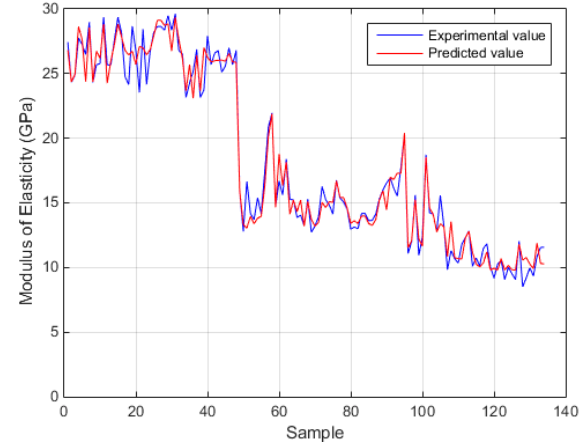
Figure 9. Experimental vs predicted values of modulus of elasticity for the best with two hidden layers BPNN